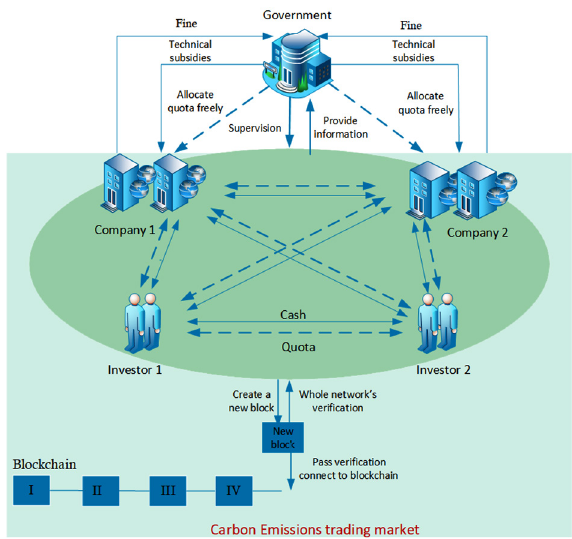
Figure 5. Transaction flow chart based on private chain